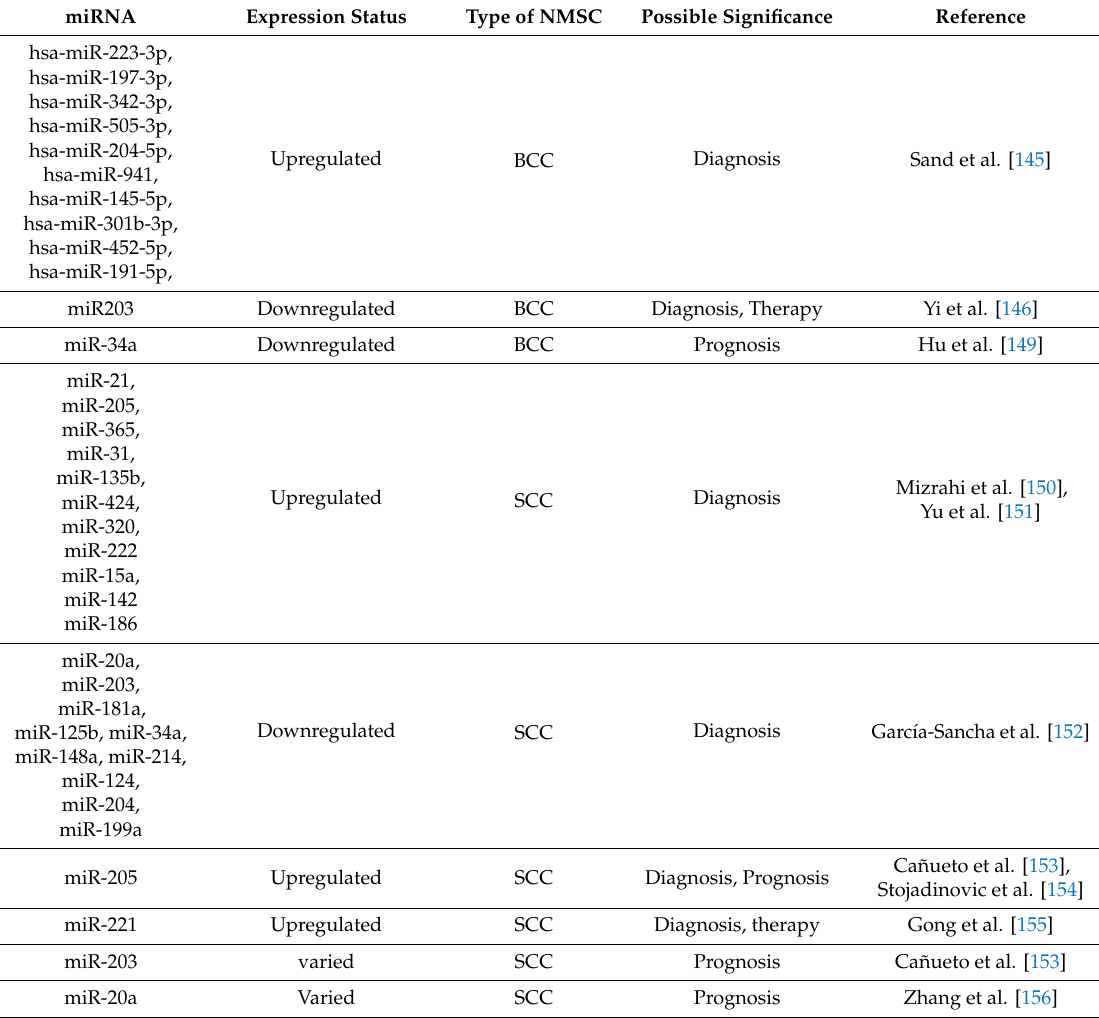
Table 2. Deregulated microRNA expression profiles and their clinical relevance for NMSC. miRNA Expression Status Type of NMSC Possible Significance